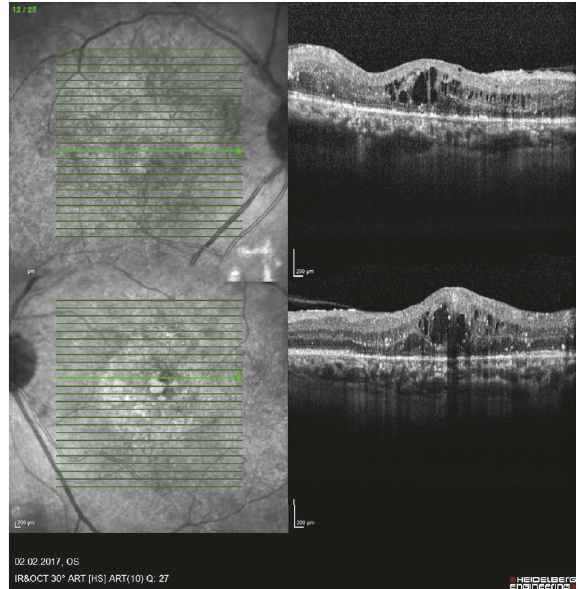
Figure 5: Three months later both eye’s serous retinal detachments disappeared (superior image is right eye and inferior image is left